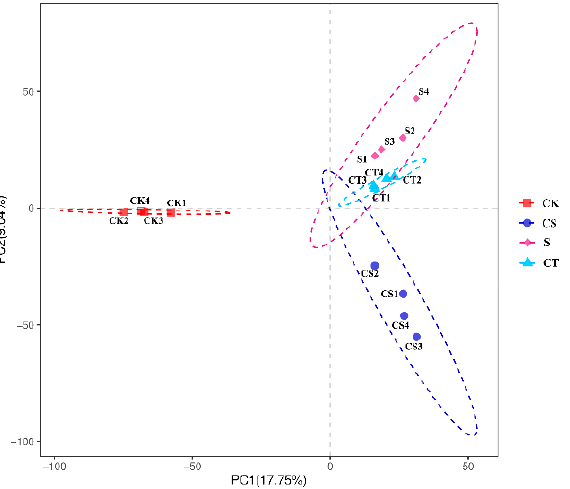
Figure 3. Analysis of the phoD microbial community structure in different fertilizer treatments by PLS-DA.